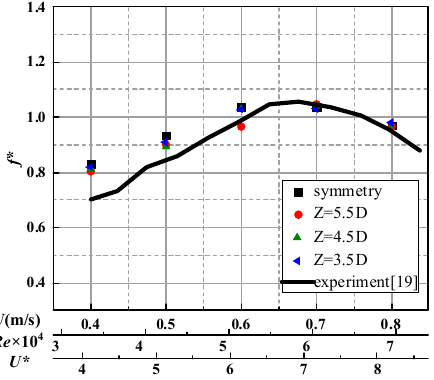
Figure 15. The frequency ratio ( f* ) of the PTC cylinder.